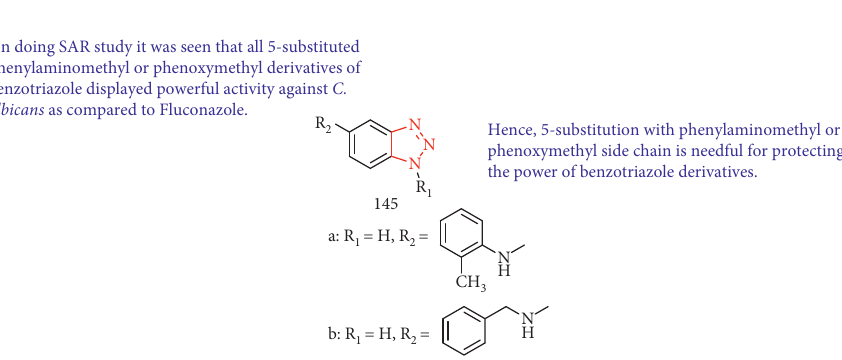
Figure 76: Chemical structure of benzotriazole derivatives as novel antifungal